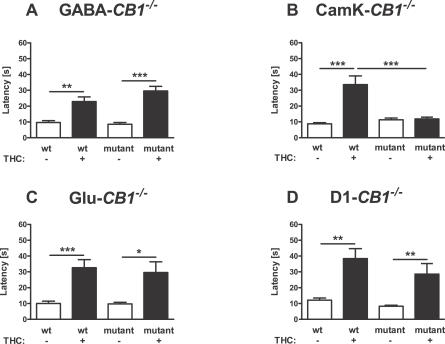
Analgesic Effect of THC in Different CB1 Mutant MiceLatency to show signs of discomfort on a 55 °C hot plate was measured 75 min after the injection of 10 mg/kg THC or vehicle. A 60-s cut-off time was applied. *, **, ***; p < 0.05, p < 0.01, p < 0.001, respectively (two-way ANOVA, followed by Newman-Keuls post-hoc test). Note that THC has a normal effect in GABA-CB1
−/− (A), in Glu-CB1
−/− (C) and D1-CB1
−/− mice (D), but no effect in CaMK-CB1
−/− mice (B). See Materials and Methods for number of animals in each group.